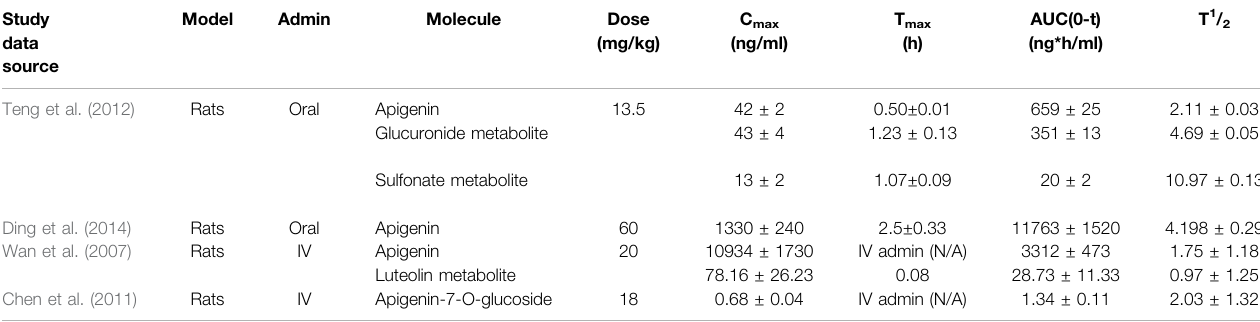
TABLE 1 | Pharmacokinetic parameters of apigenin in the literature. Four kinetic studies on oral and IV administered apigenin in rat models have been published. Doses ranged from 13.5 to 60 mg/kg. Signi fi cant variability was observed between peak plasma concentrations and the respective T max . Relative oral bioavailability (F) of apigenin is low, at ∼ 30%. Note: parameters were calculated to equivalent